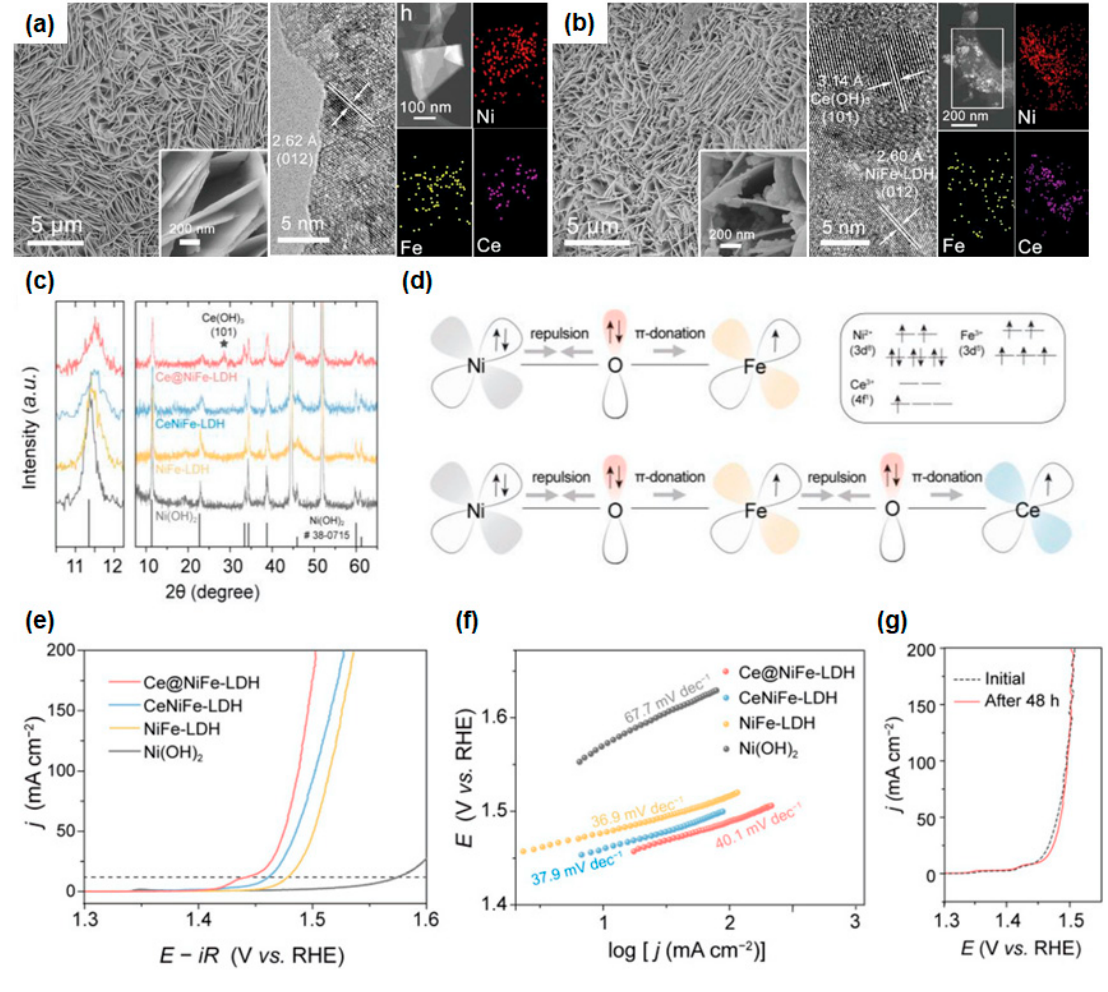
Figure 5. SEM, high-resolution TEM, HAADF-STEM images, and the corresponding EDX elemental mappings of ( a ) CeNiFe-LDH and ( b ) Ce@NiFe-LDH nanosheets. ( c ) XRD patterns of as-prepared Ce@NiFe-LDH and CeNiFe-LDH. The data for Ni(OH) 2 , NiFe-LDH, and Ce(OH) 3 are shown for comparison. ( d ) Schematics of the electronic interplay among Ni, Fe, Ce, and O in NiFe-LDH, CeNiFe-LDH, and Ce@NiFe-LDH. ( e ) LSV curves. ( f ) The corresponding Tafel plots of Ce@NiFe- LDH, CeNiFe-LDH, NiFe-LDH, and Ni(OH) 2 for OER. Measured O 2 yields at 0.3 V. ( g ) LSV curves of Ce@NiFe-LDH before and after 48 h electrolysis. Reprinted (adapted) from reference [138],